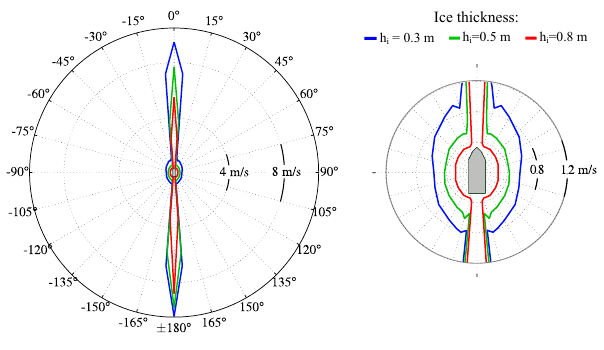
Figure 10: DP-Ice Capability Plot parameterized by varying ice drift speed for three different ice thicknesses. Courtesy: Su et al. (2013)